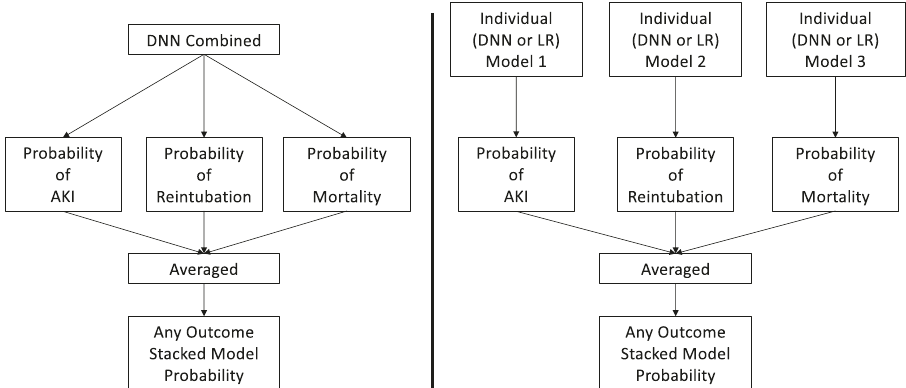
Fig. 1 Visual depiction of the any outcome stacked models. Summary fi gure describing the stacked “ any ” postoperative outcome models for the combined deep neural networks (DNN combined) trained to output probabilities of all three outcomes vs the deep neural networks (DNN individual) and logistic regression (LR) models that were individually trained per